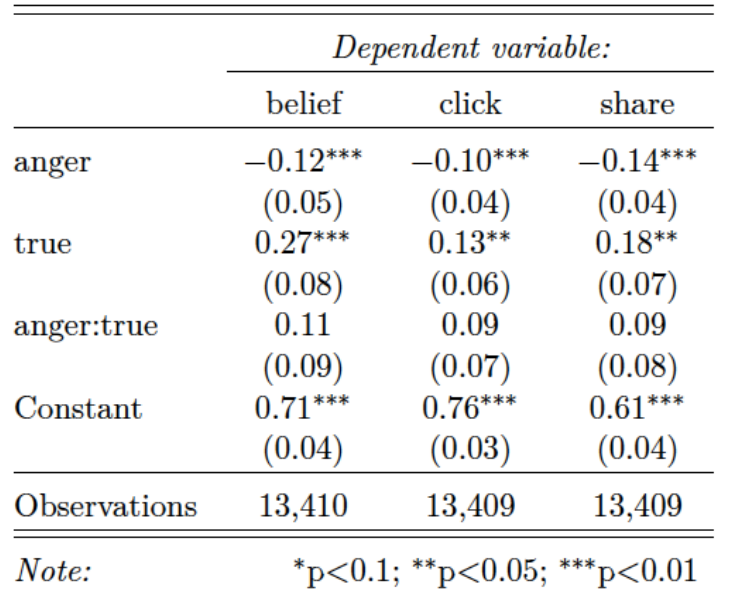
Table B4. Association between anger and belief, click, and share.